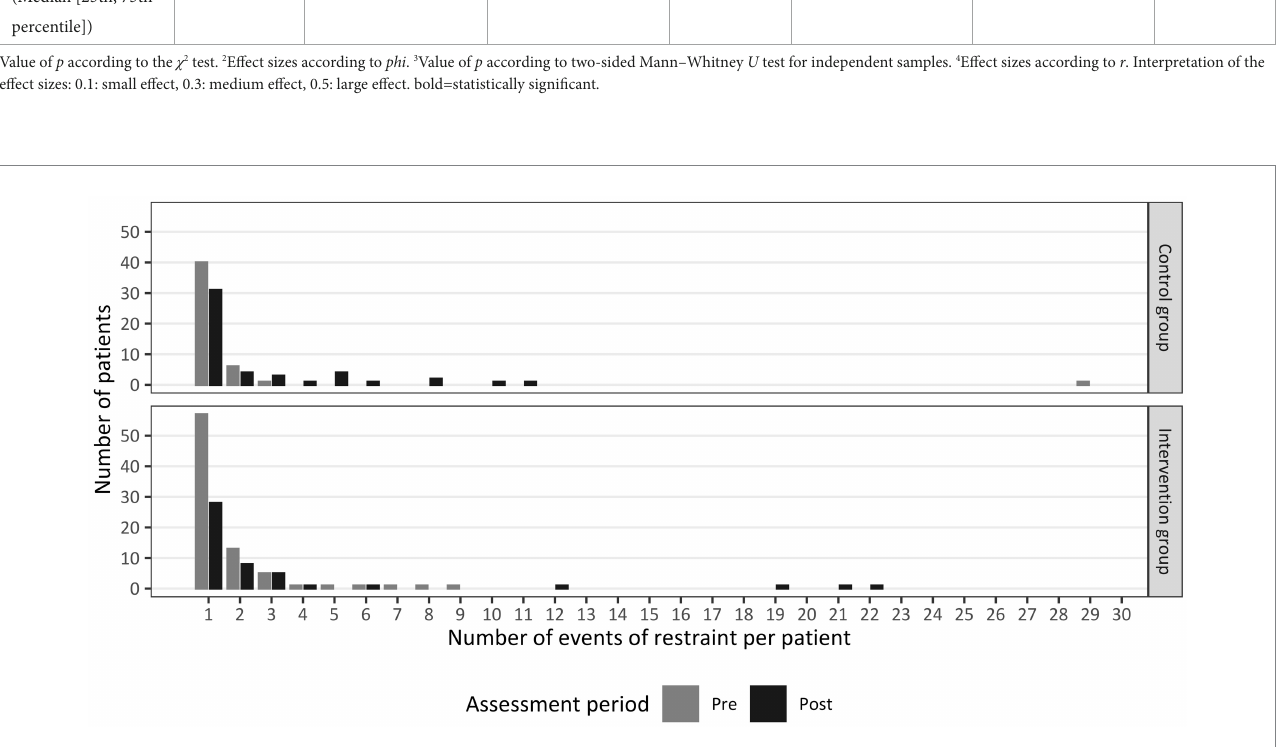
FIGURE 1 Number of events of restraint per patient separated by group (Intervention Group or Control Group) before (pre) and after (post) the implementation of peer support ( n t0 = 116, n t1 =